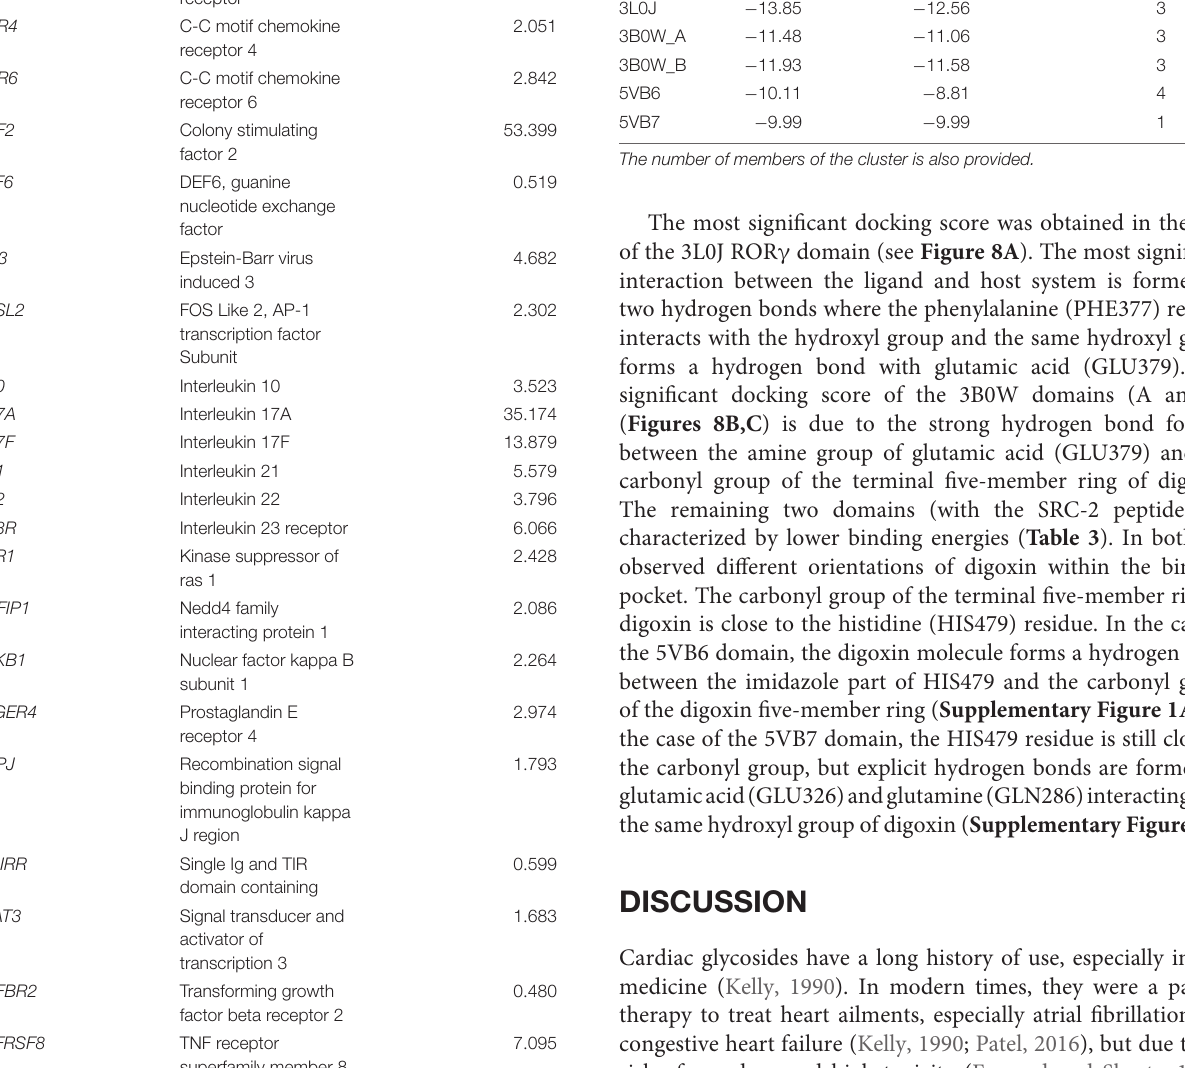
Fold change: the difference in gene expression levels between digoxin-treated and untreated Th17 cells was counted as a mean from the fold change of DESeq, DESeq2 and edgeR analyzes.